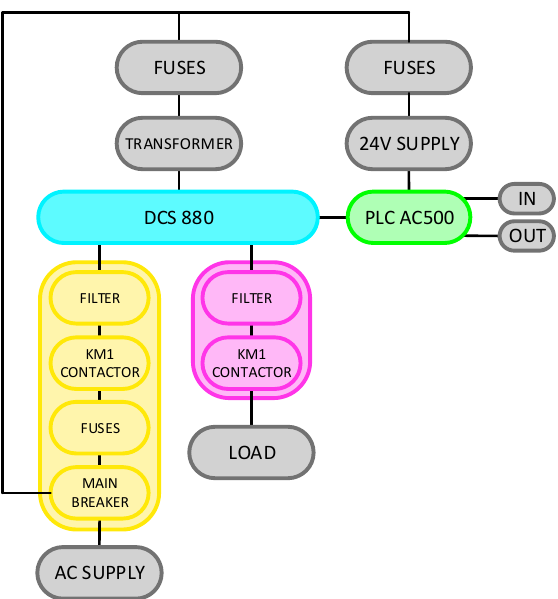
Figure 4. A sketch of the laboratory-assembled electrical panel.